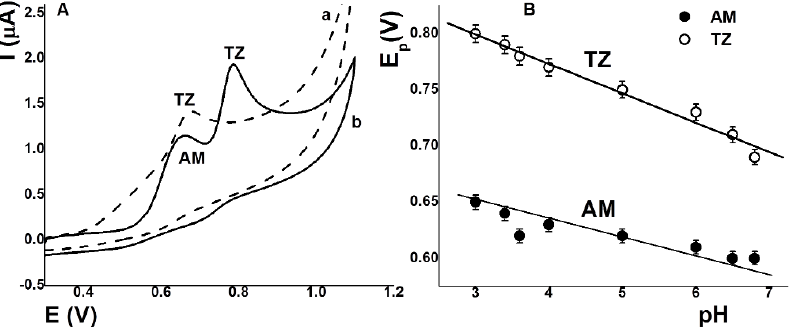
Figure 1. ( A ) Cyclic voltammograms (CV) of AM and TZ solutions (17.7 µmol L –1 ) in the presence of nitric acid solution (pH 3.2, curve a), and in the presence of phosphoric buffer solution (pH 6.8, curve b). Scan rate 50 V s −1 . ( B ) Effect of pH on anodic peak potentials for AM (•) and TZ (o) using screen-printed carbon electrode.